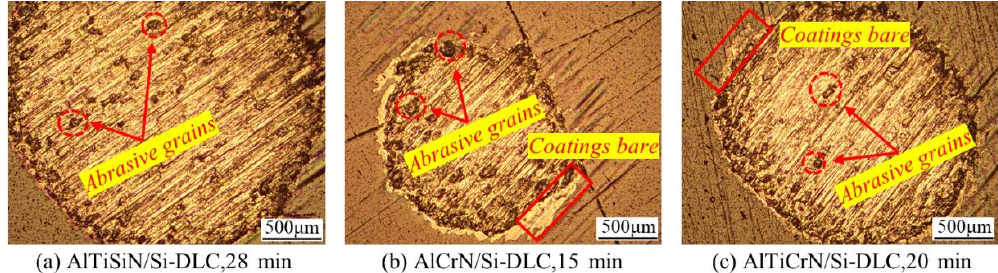
Figure 11. Adhesive wear morphology of Si-DLC with different transition layers.